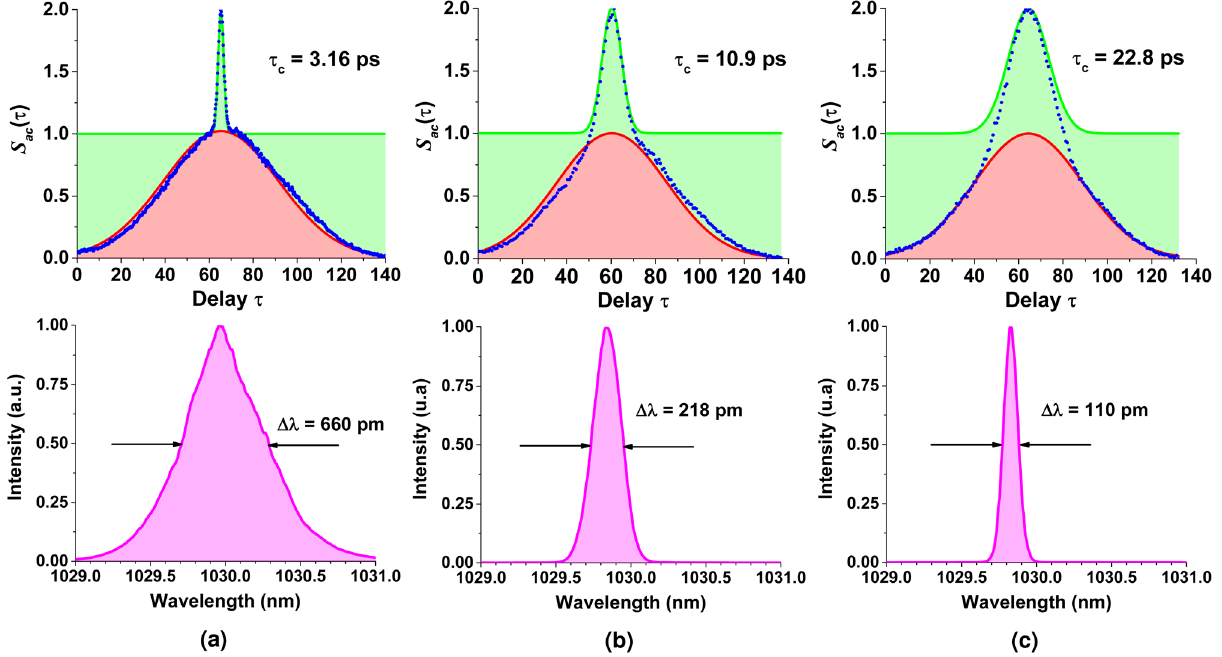
Figure 6. Top panels: experimental normalized autocorrelation traces of the pulsed ASE source for 3 different coherence time. The green and red curves correspond to the extracted first order correlation function 1 + | g ( 1 ) (τ) | 2 and the gate autocorrelation Q (τ) respectively. The pulse duration is in this case 42 ps. The coherence time τ c varies from 3.2 to 22.8 ps. Bottom panels: measured corresponding (cid:31) (cid:30)